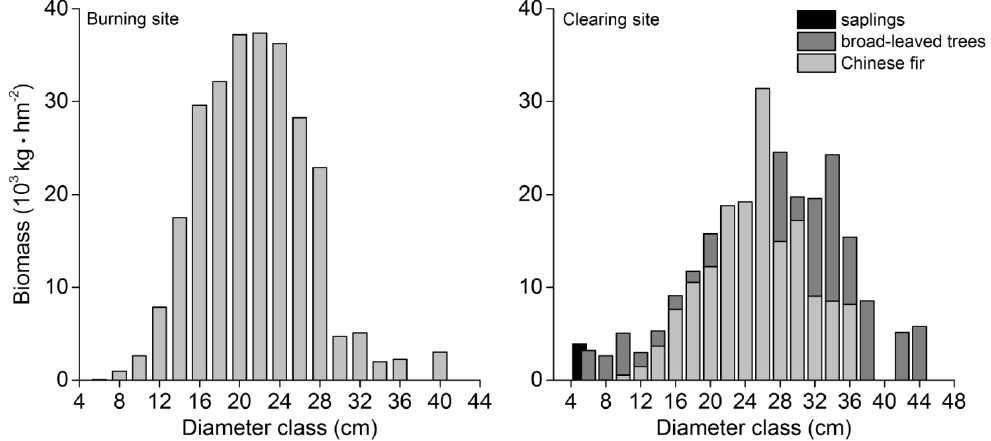
Figure 5. Biomass distribution of each diameter class for the controlled burning and brush clearing sites.